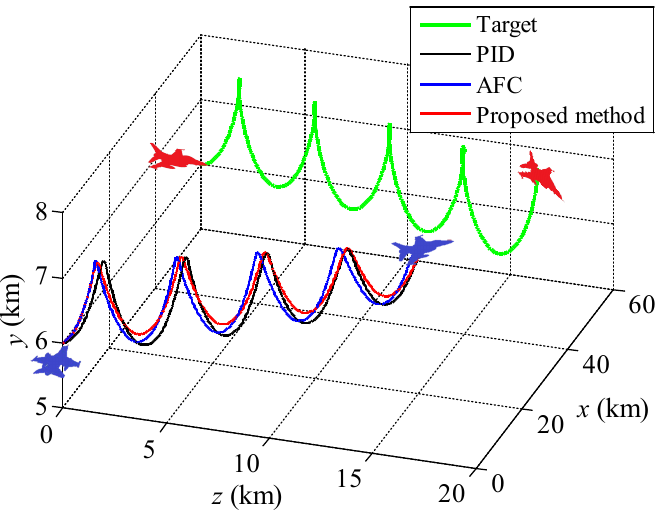
Figure 14. Attack guidance trajectories for the barrel roll maneuvering of the target.